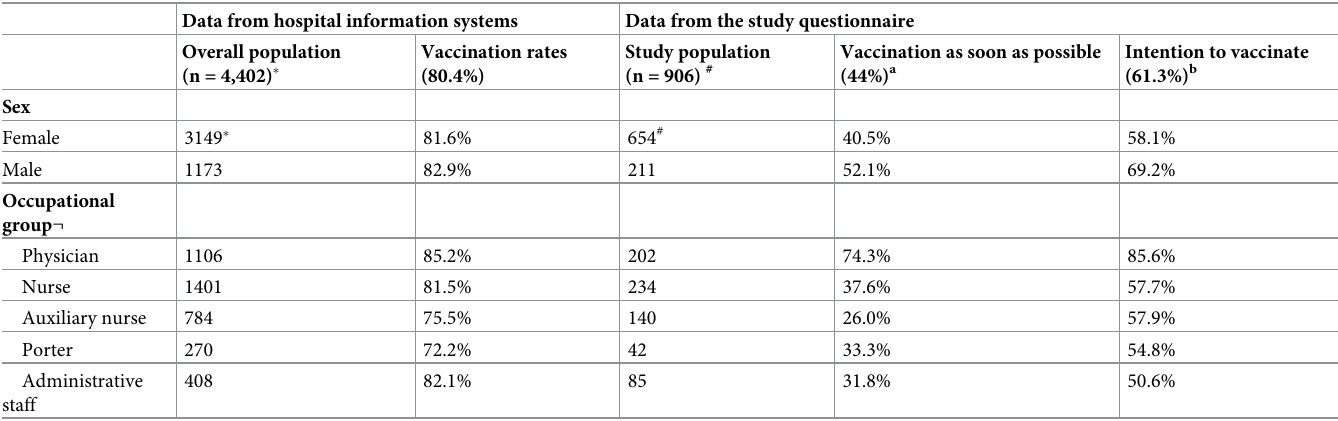
Table 4. COVID-19 vaccination rates vs. previous intention to